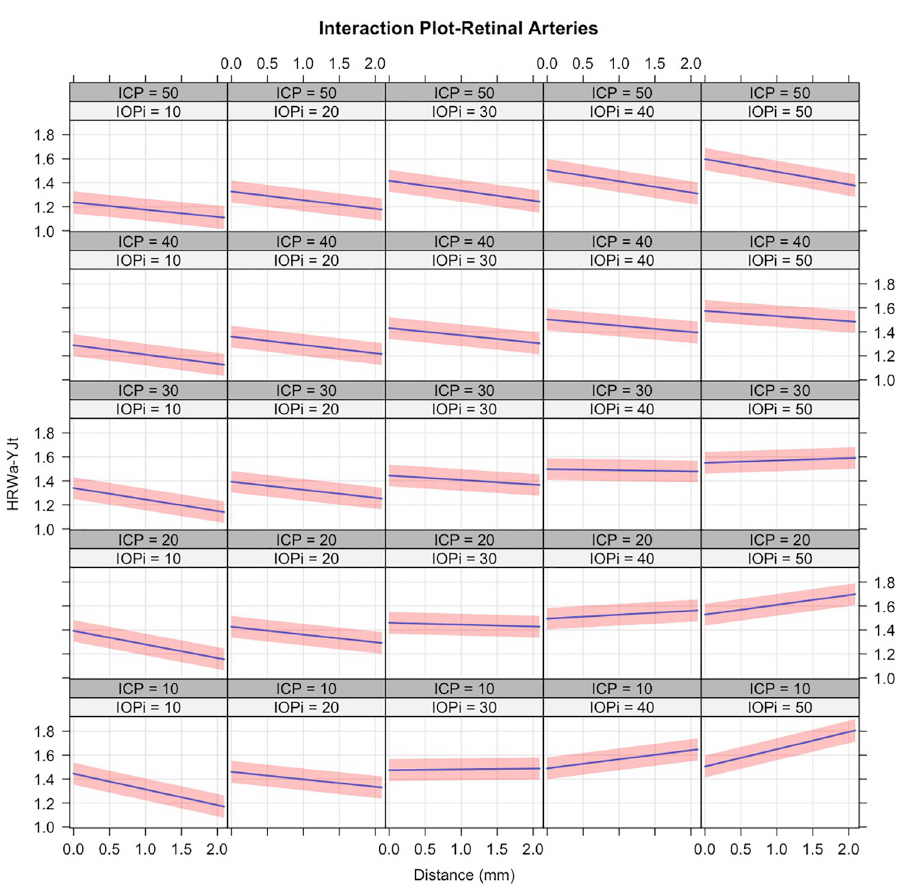
Fig 7. Trellis graph demonstrating the mixed effects linear regression model with interactions of the Yeo-Johnson transformed arterial harmonic regression waveform amplitude (HRW a-YJt ). Distance is measured in millimeters (mm) from the center of the optic disc. The 95% confidence intervals are shown around the regression lines. Noted is a increase of the slope of the regression with increased ICP (columns) and IOP i (rows) particularly with ICP in the pathological range. Contrary to the retinal veins the progressively higher y-intercepts of the regression lines along the lower left to upper right diagonal indicate that amplification of the retinal arterial pulsation occurs with a higher ICP. A reversal of the slope of the regression at ICP 10–20 at an IOPi > 30 mmHg is seen, this is likely a spurious result as a consequence of the boundary conditions of the mixed effects linear